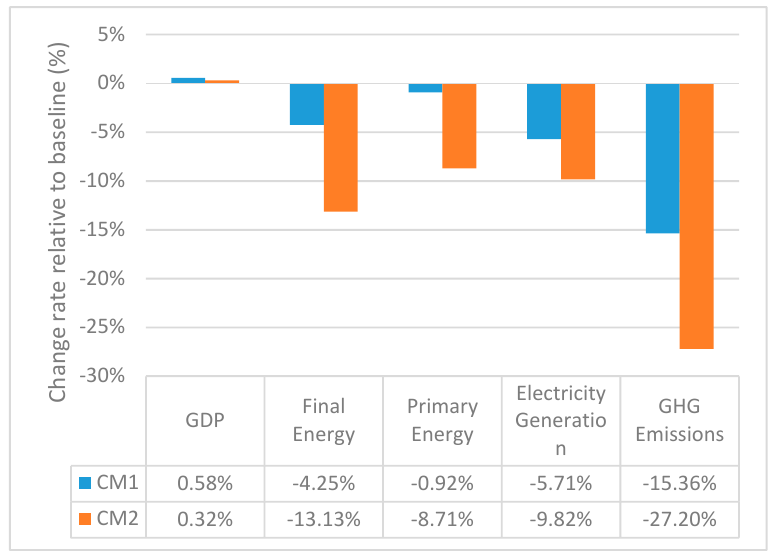
Figure 7. Percent change in GHG emissions, energy, and GDP by 2030 (relative to baseline values).